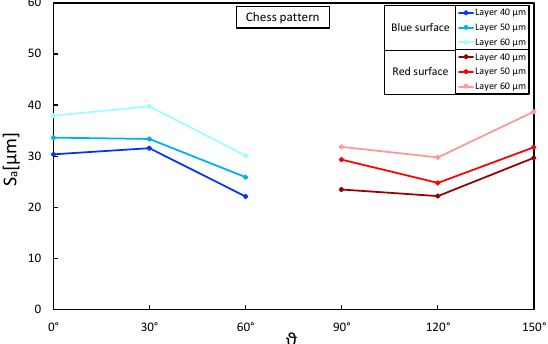
Figure 7. S a as a function of layer thickness ( t ) and building angle ( θ ): chess laser pattern.